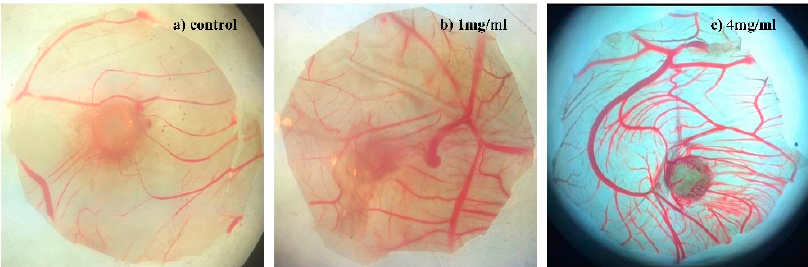
Figure 4. Microvascular proliferation of compound 8 on chick chorioallantoic membrane (CAM) (×50). ( a ) Blank control group, ( b ) 1 mg/mL for compound 8 group, and ( c ) 4 mg/mL for compound 8 group.